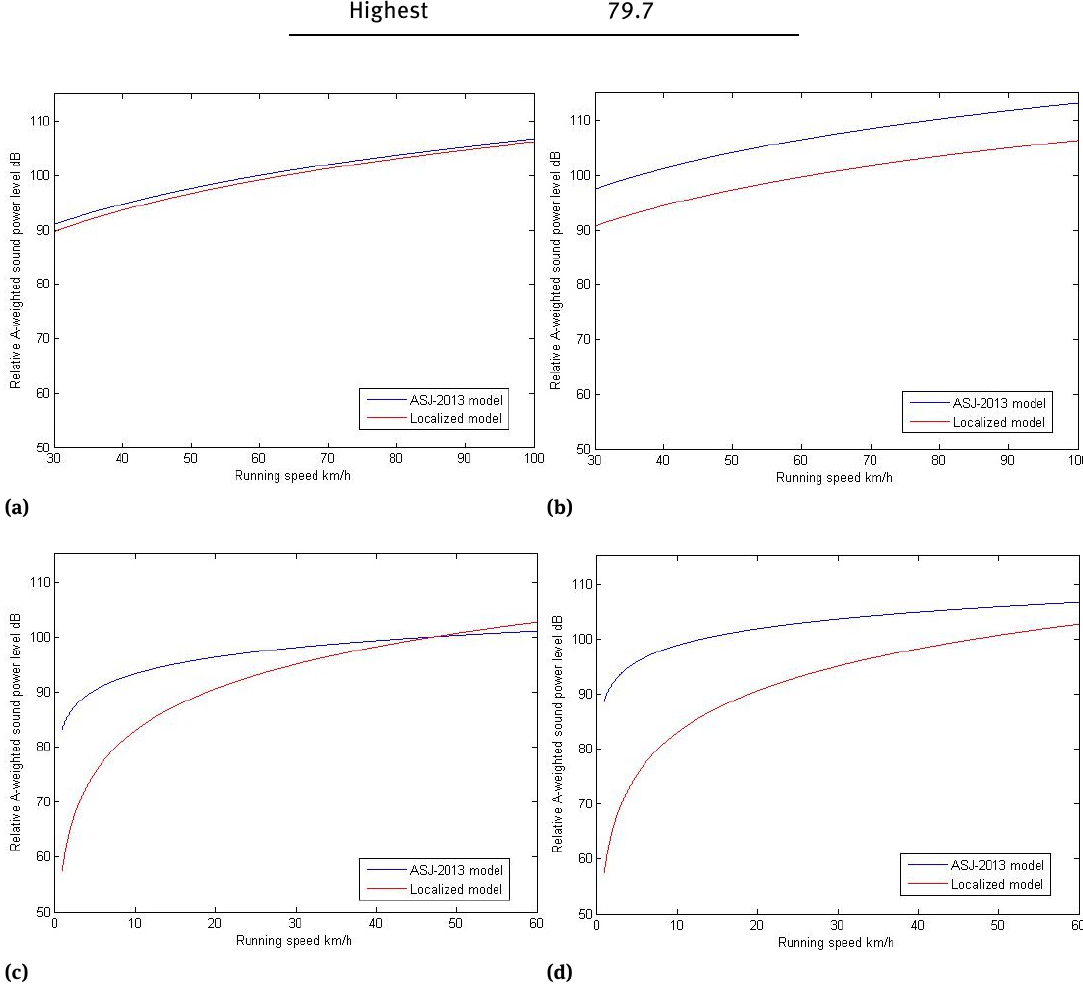
Figure 1: A-weighted sound power level of the ASJ-2013 model and the localized model: (a) Light vehicles for steady status, (b) Heavy vehi- cles for steady status, (c) Light vehicles for non-steady status, (d) Heavy vehicles for non-steady